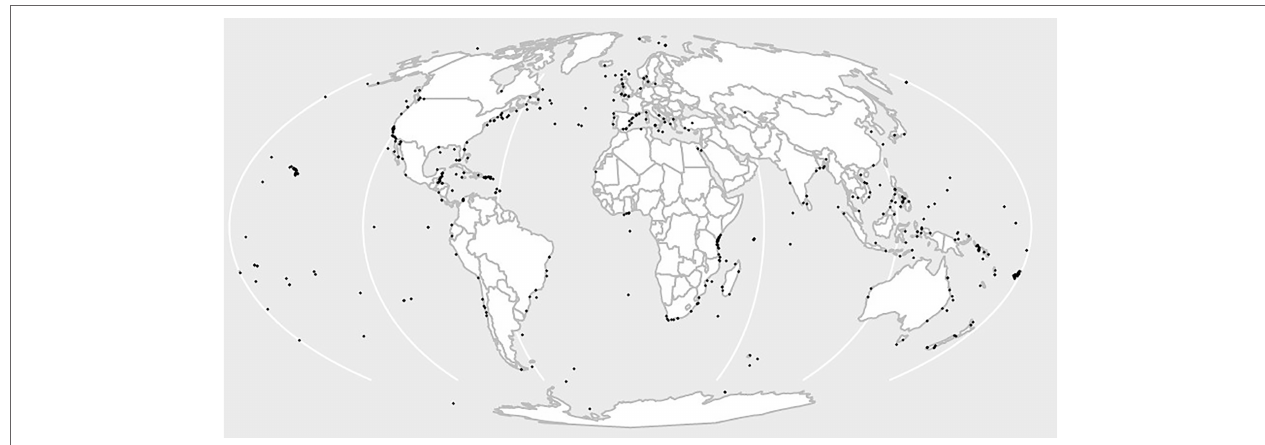
FIGURE 2 | Locations of the unique fisheries ABMT case studies included in this